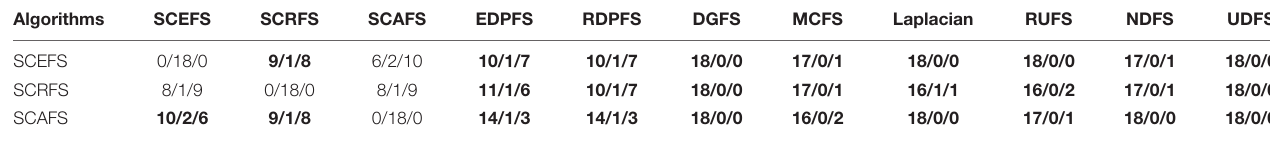
FIGURE 7 | The maximal mean F2 comparison of each algorithm on 18 datasets using KNN classifier. TABLE 5 | The comparison between proposed algorithms and other compared algorithms in terms of win/draw/loss based on the maximal mean F2.